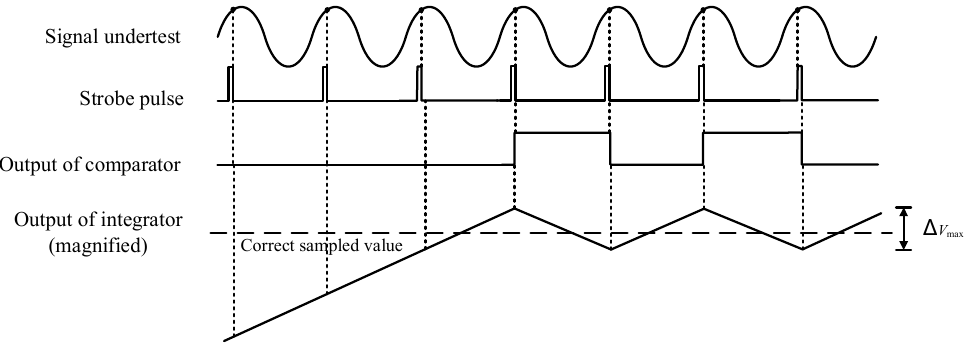
Figure 7. Corresponding waveform diagram of each signal.